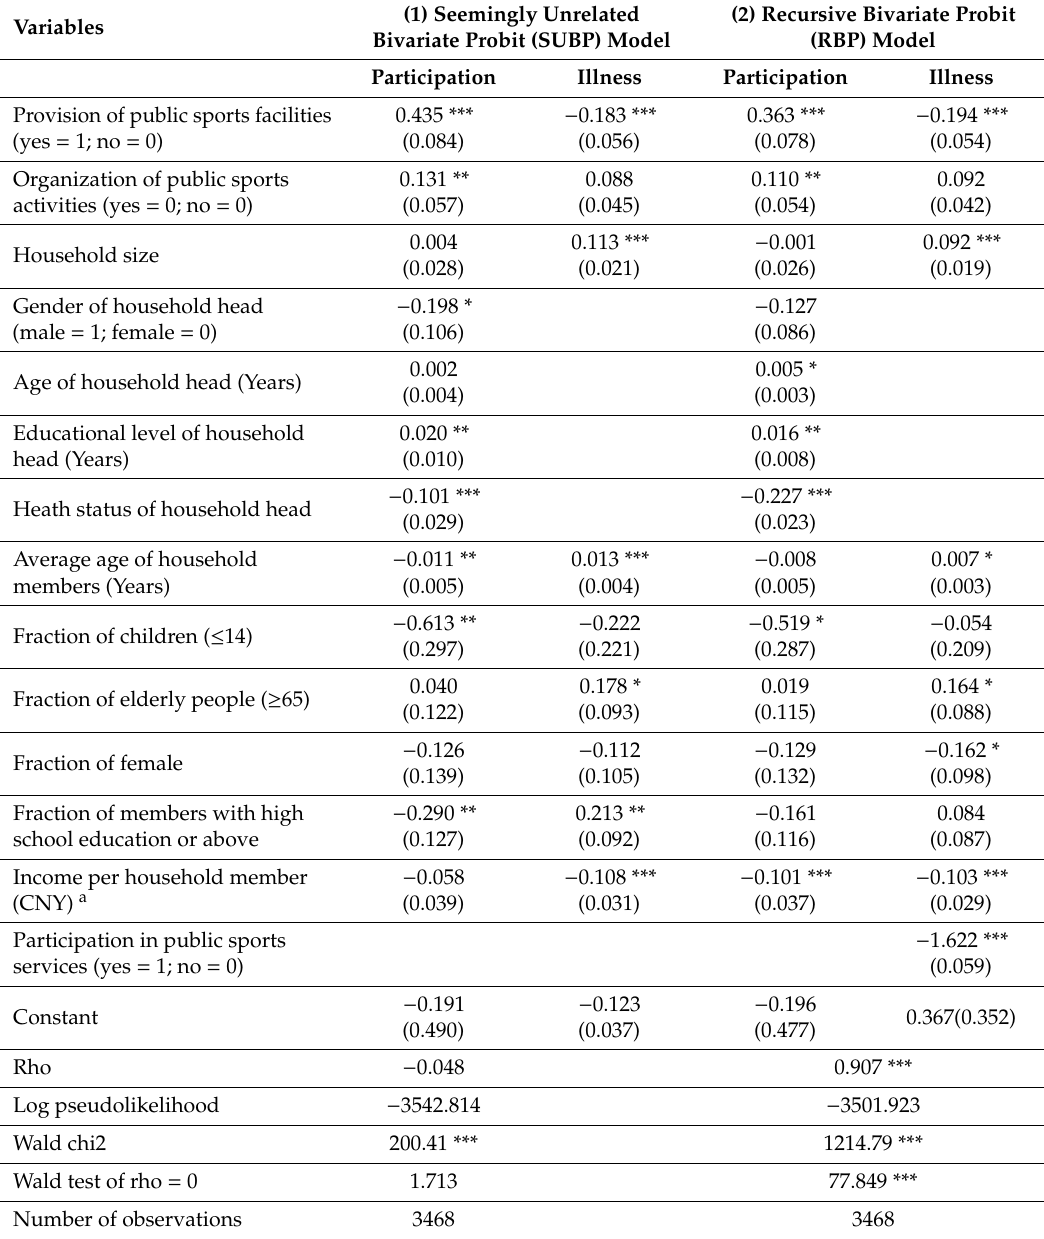
Table 4. E ff ects of community sports provision on social inclusion and public